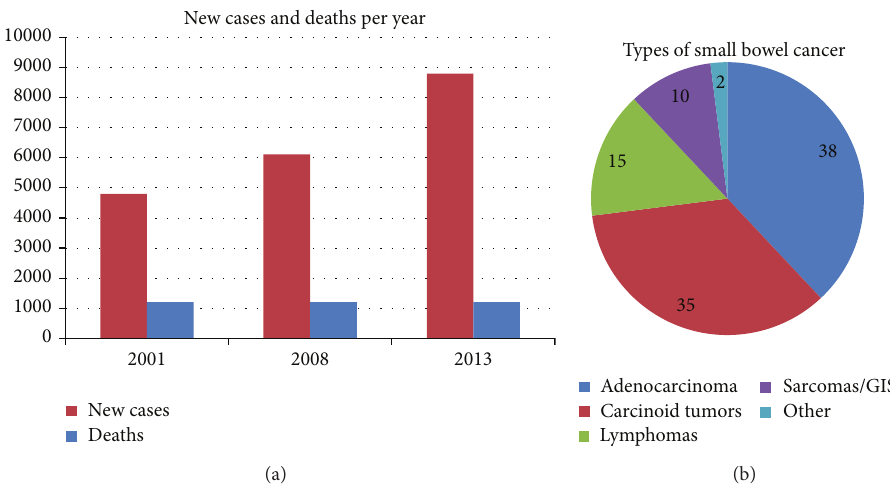
Figure 2: Charts showing epidemiological data for the US